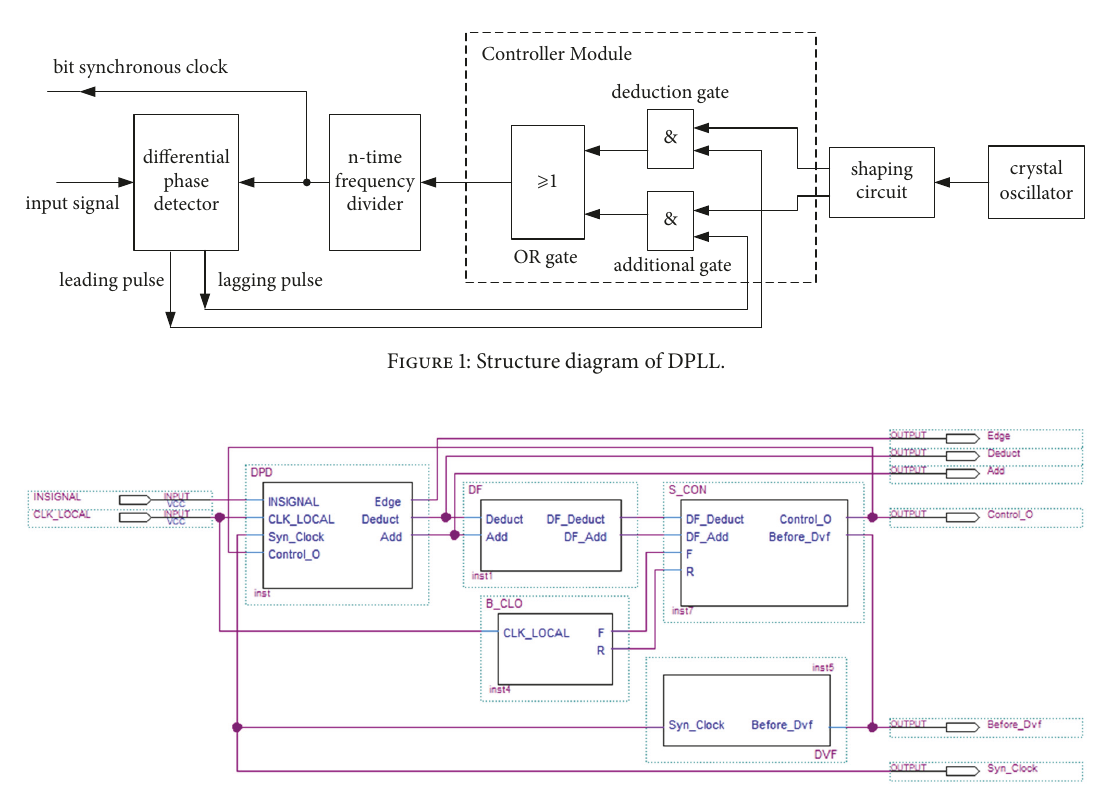
Figure 2: Schematic of bit synchronization clock extraction system based on